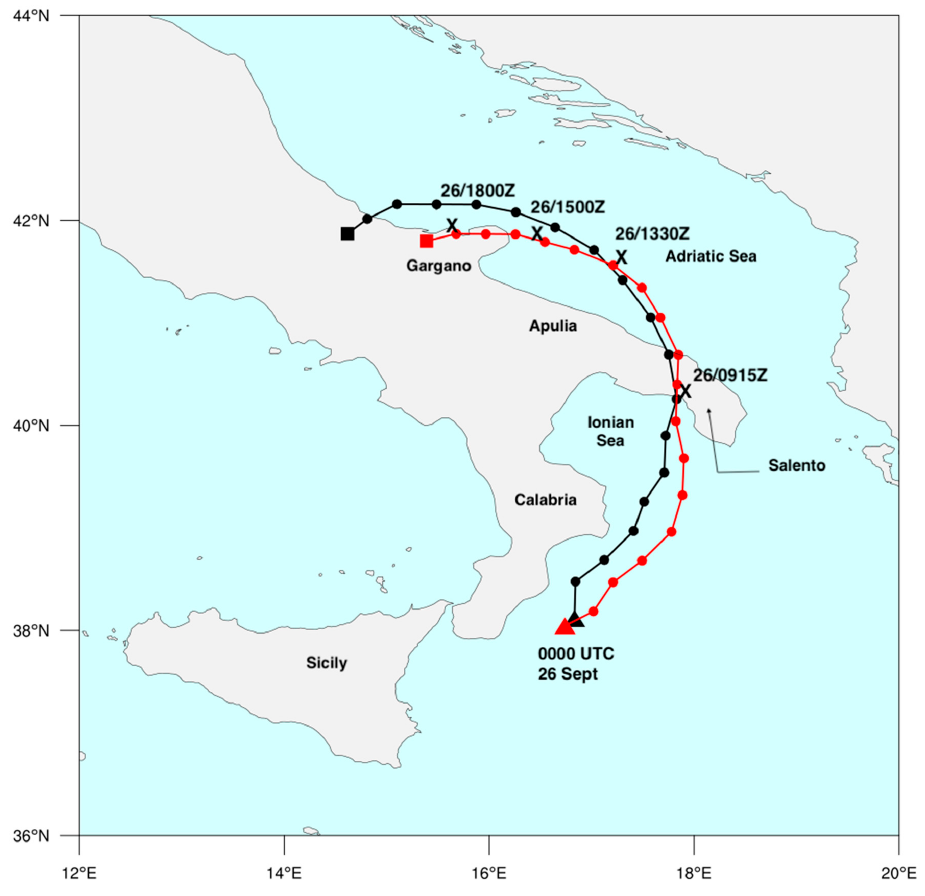
Figure 7. Cyclone track starting 0000 UTC 26 September 2006 of CPL0 run (continuous black line); CPL5 run (continuous red line). X points denotes the track of cyclone from radar-map images and their timing in DD/HHMM format.